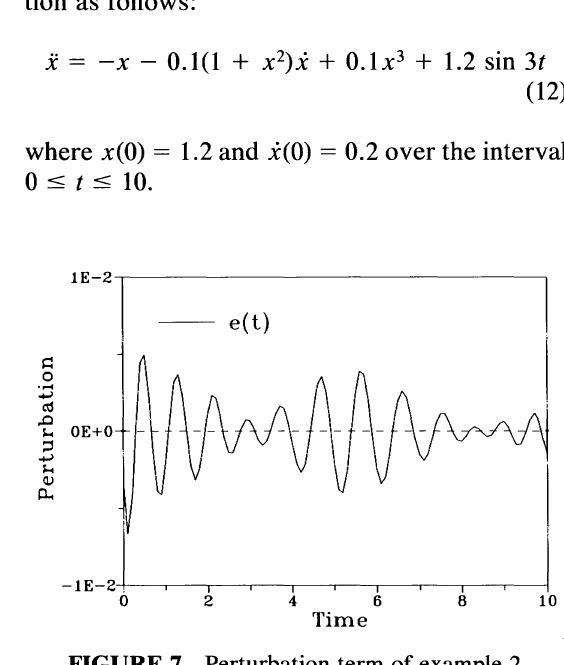
FIGURE 7 Perturbation term of example